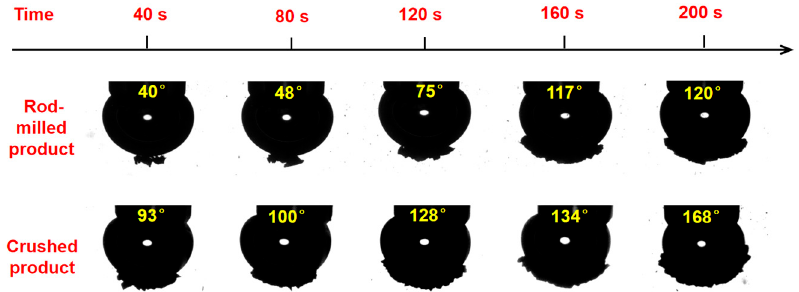
Figure 8. Wrap angles of low-rank coal particles (different comminution methods) adhered to the bubble surface for different stirring times.